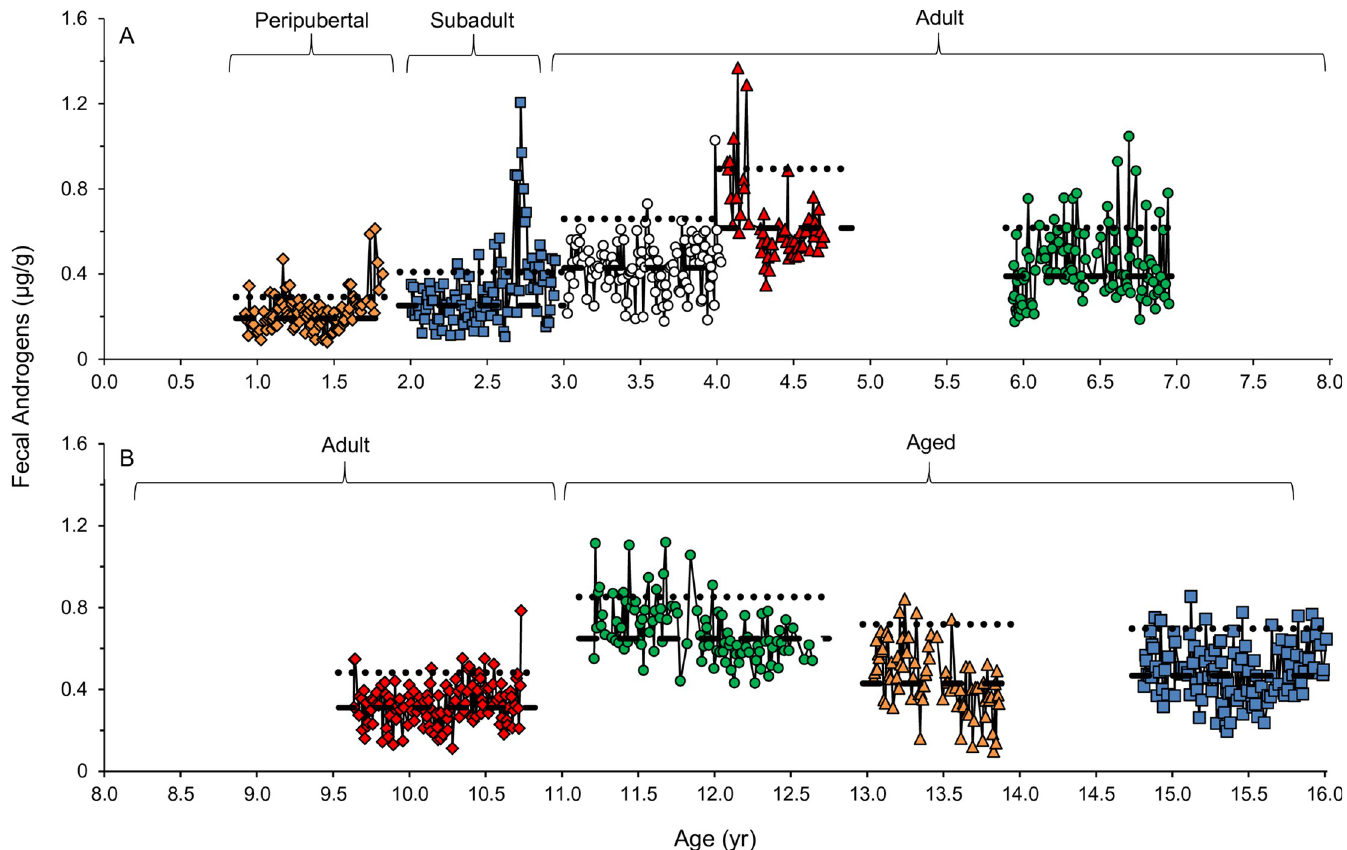
Fig 1. Representative fecal androgen metabolite ( μ g/g) profiles of nine males of diverse ages. Panel A; Peripubertal (0.9–2 yr): SB411 (orange diamonds), Subadult (2–2.99): SB248 (blue squares) and Adult (3–10.99): SB215 (open circles), SB225 (red triangles) and SB146 (green circles). Panel B; Adult: SB148 (red diamonds) and Aged ( > 11 yr): SB221 (green circles), SB173 (orange triangles) and SB75 (blue squares). Baseline (dashed line) and threshold (dotted line) concentrations were calculated for each male.